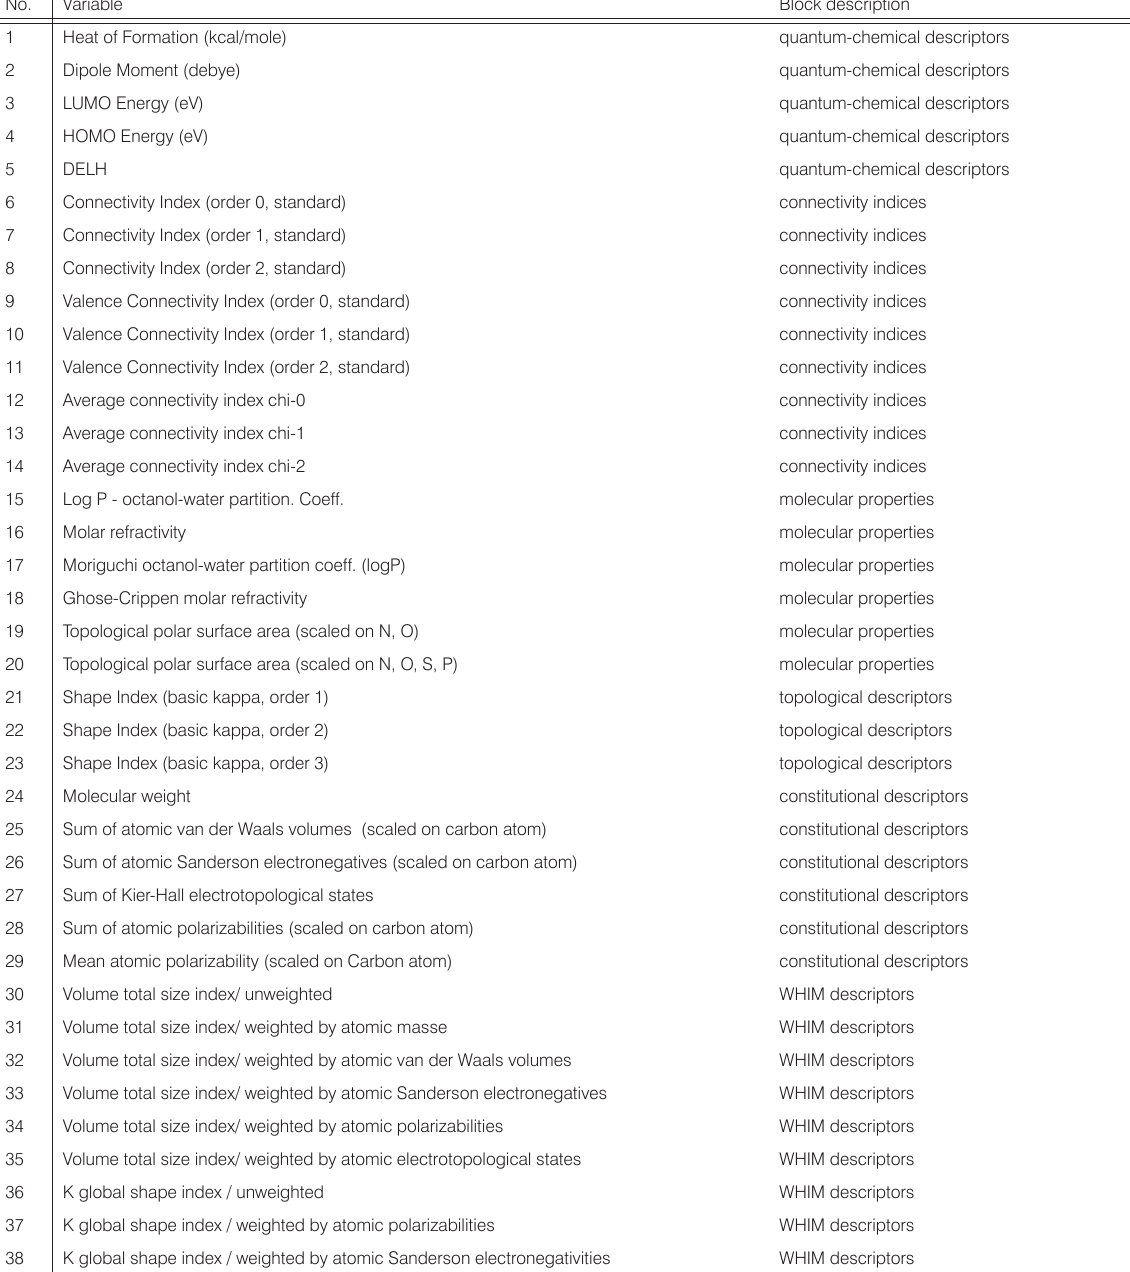
Table 1. Molecular descriptors used in ANN